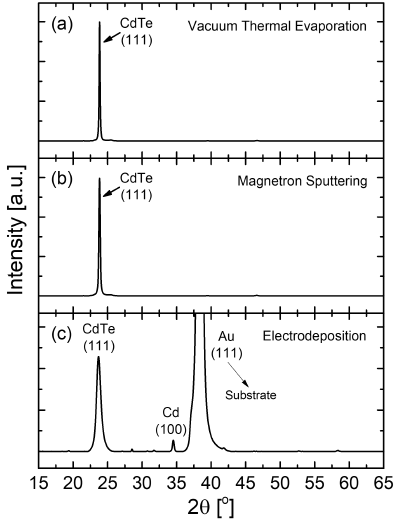
Figure 5. X-ray diffraction (XRD) characterization of CdTe thin films deposited by VTE ( a ), RF-MS ( b ), and ECD ( c ). VTE and RF-MS thin film control samples were prepared using pristine optical glass substrates, while ECD test samples were synthesized using a common Au-coated Si